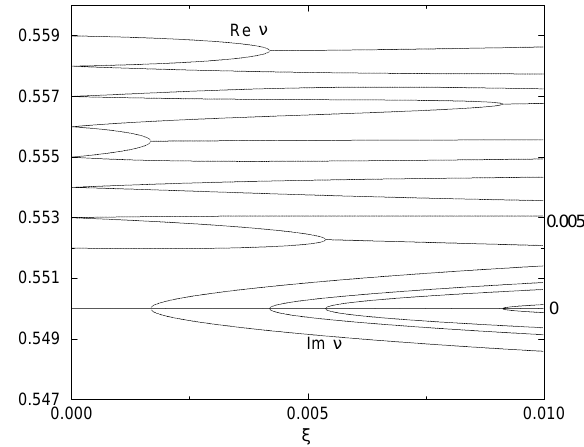
FIG. 13. Eigenfrequencies (tunes) of the antiproton bunch oscillation modes vs the antiproton betatron tune shift due to the electron beam j e (horizontal axis). The vertical scale on the left is for the fractional part of the tunes Re n (upper series of lines), and the right-side scale is for the imaginary part of the tunes Im n (lower series of lines).